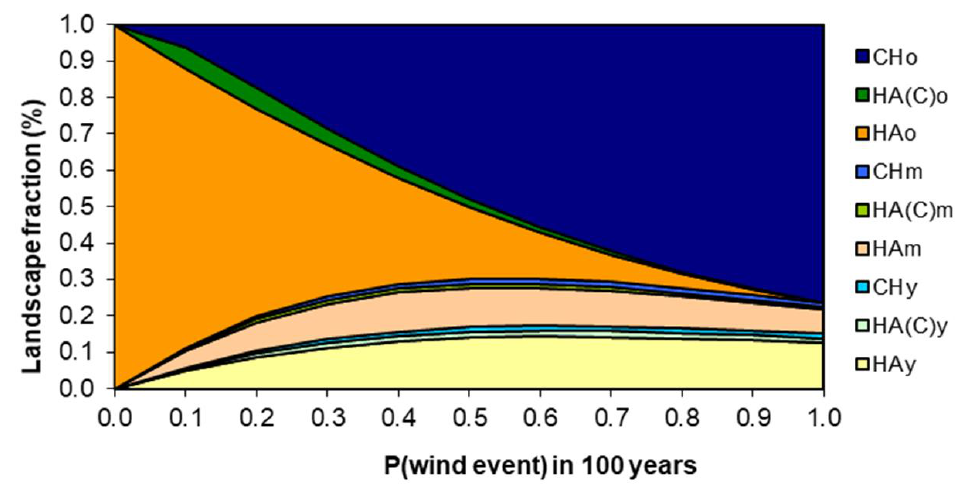
Figure 7. Landscape fraction (%) occupied by different stand types when the model is calibrated for the base case, after 3000 years of iterations for different probabilities (return periods) of windstorms.